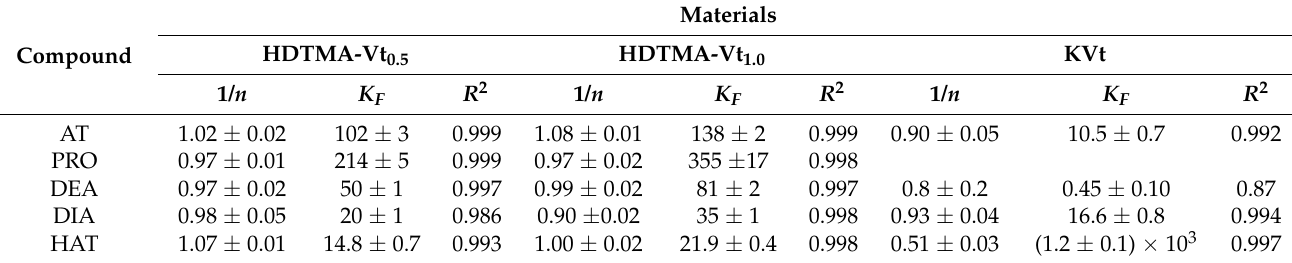
Table 4. Chemical properties and Freundlich parameters, K F ( µ mol 1n L n kg 1 ) found for the adsorption of atrazine (AT), propazine (PRO), deethylatrazine (DEA), deisopropylatrazine (DIA), and hydroxyatrazine (HAT) onto HDTMA modified vermiculite